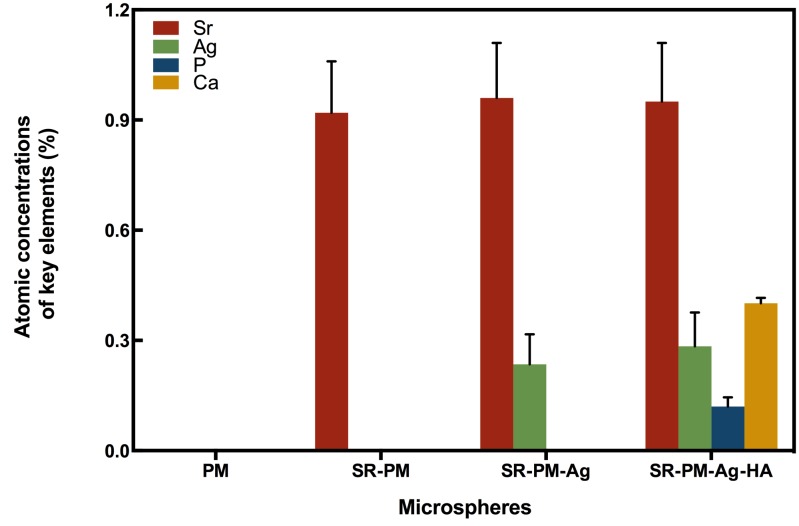
Atomic absorption spectroscopy composition of the four types of microspheres, where the data are represented as mean ± SD.